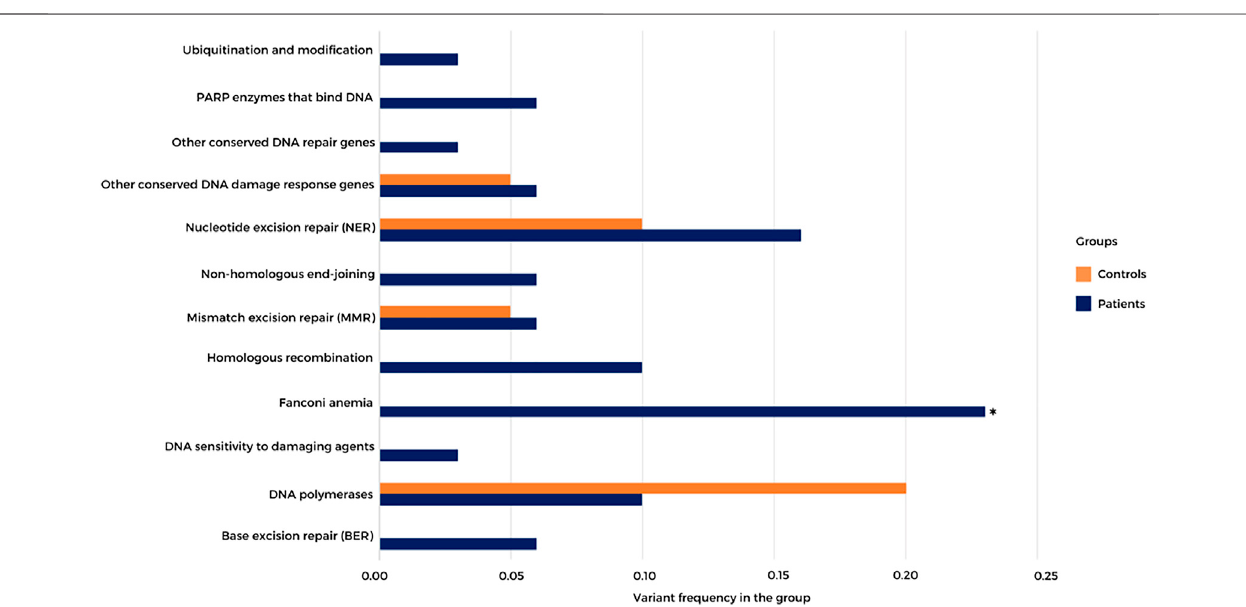
FIGURE4| Frequencyofhigh-qualityraregermlinecodingvariantsmappedtoDNArepairgenesinHBpatientsandacontrolgroup.Alistof220DNArepairgenes distributedin16categorieswasanalyzed;the12categorieswithvariantsdetectedineitherpatientsorcontrolsarerepresented. PARP — poly (ADP-ribose)polymerase. * p value 0.0338; Fisher ’ s